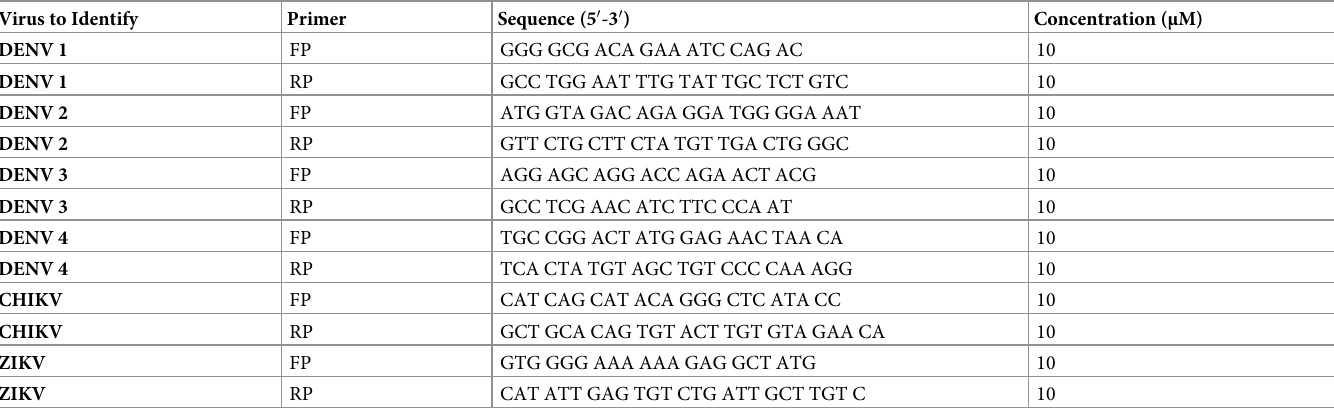
Table 1. Sequences and working concentrations of primers designed for the confirmation of coinfections. Virus to Identify